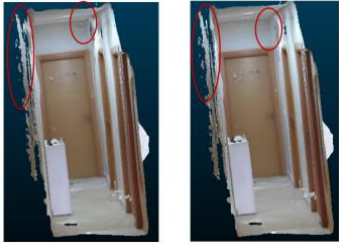
Figure 15. Corridor case: raw point cloud on the left and point cloud from filtered depth images on the right.